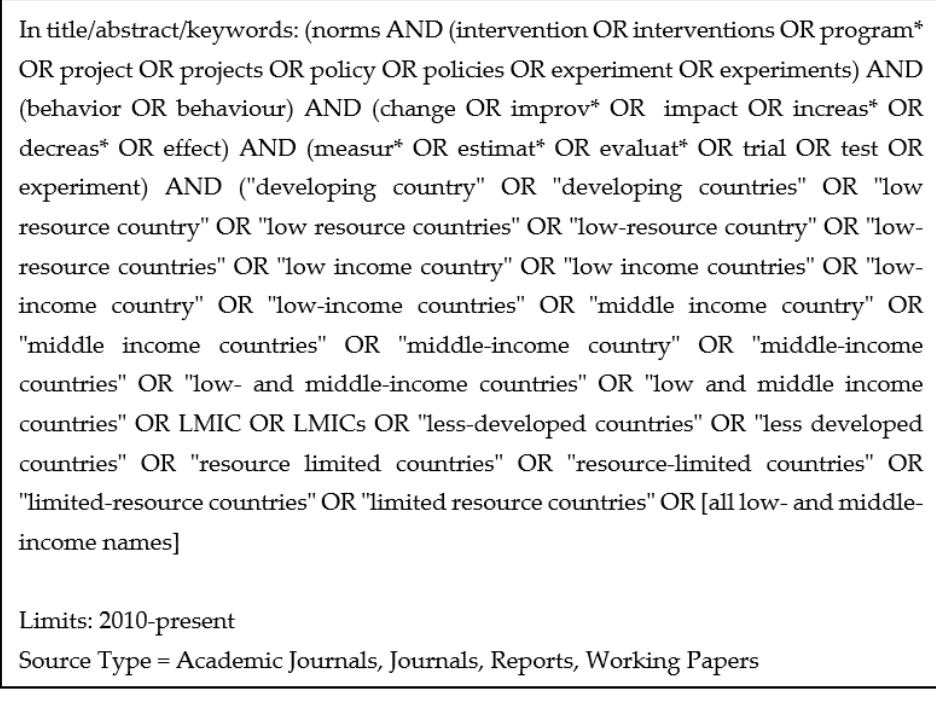
Figure 1. Search strategy for EBSCO platform.